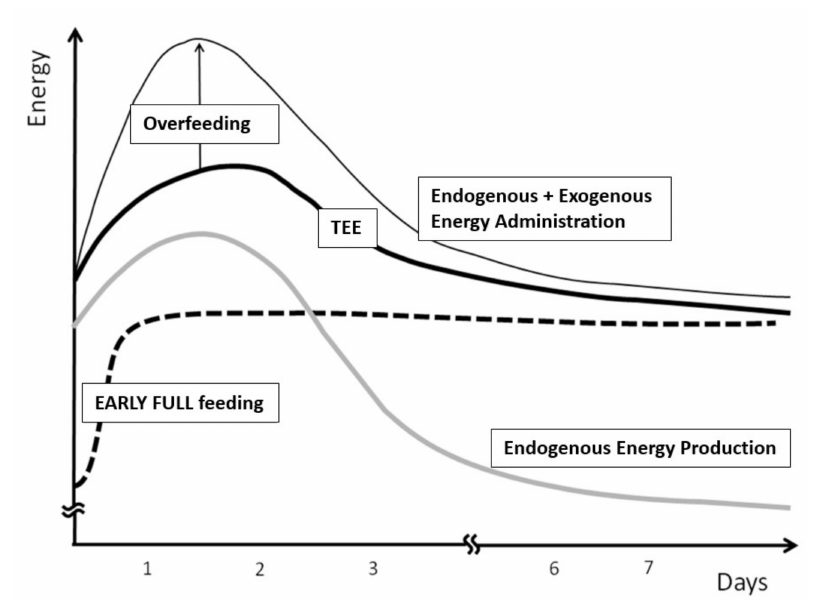
Figure 5. Conceptual representation of the relative overfeeding commonly resulting from early full feeding during the first days of critical illness. During this phase, the endogenous glucose production (EGP) is increased, covering up to two-thirds of total energy expenditure (TEE—solid black bold line). Full feeding in this phase will results in overfeeding, as the EGP is not attenuated by energy administration (di ff erent form healthy): exogenous feeding adds to the EGP resulting in an excessive energy availability, superior to TEE. (Solid black bold line: TEE; grey bold line: adapted endogenous energy production; dotted bold line: early energy administration; thin line: combined endogenous and exogenous energy administration). Reproduced with permission from [1].